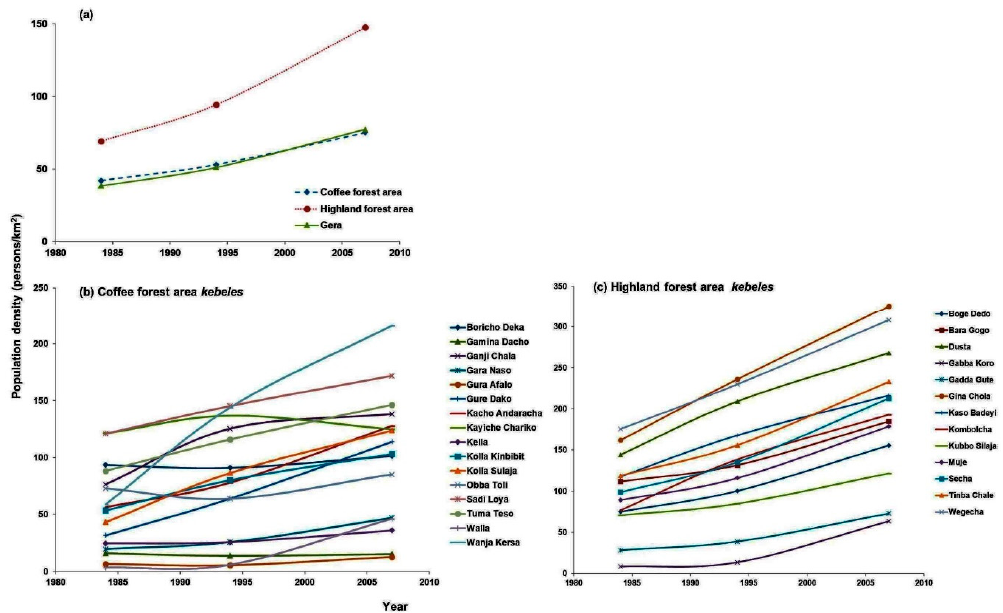
Figure A2. Population densities in 1984, 1994, and 2007 for Gera ( a ) and kebeles in coffee ( b ) and highland ( c ) forest areas. Areas designated as state forest and Chira town included in the density estimation for Gera while Chira town was excluded from the density estimation for the coffee forest area ( a ).